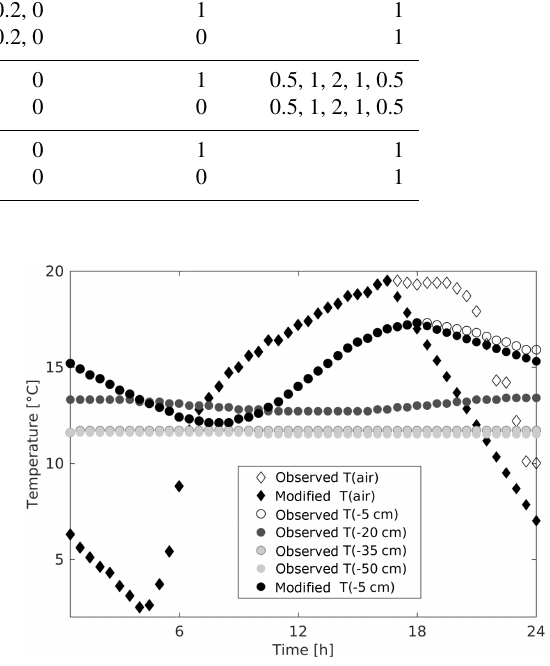
Figure 2. Daily variation of air and soil temperatures in the time step test. Observed temperatures are directly from measurement data, but in order to smooth the difference between the last and first temperatures of the day, we modified the afternoon temperatures as shown in the